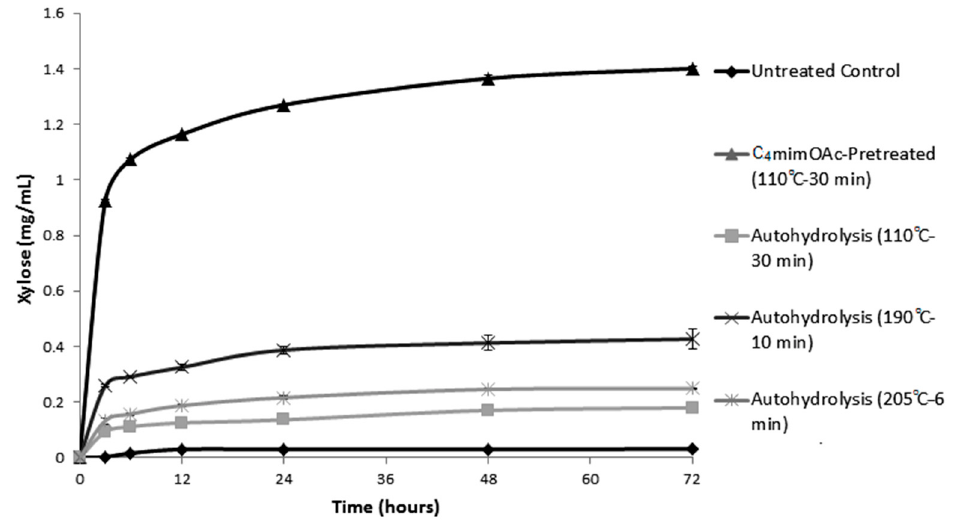
Figure 2. Xylose concentration (mg/mL) obtained after enzymatic hydrolysis of autohydrolysis and C 4 mimOAc-pretreated bagasse.